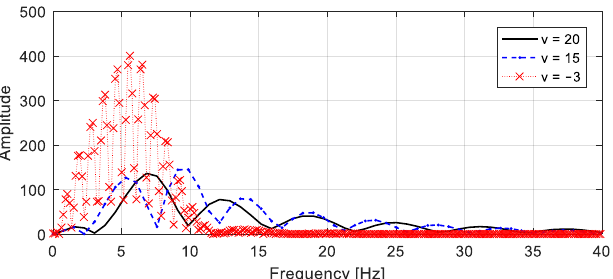
Figure 11. Frequency spectrum of the vehicle acceleration along DOF u 1 with velocities of [20, 15, − 3] m/s.